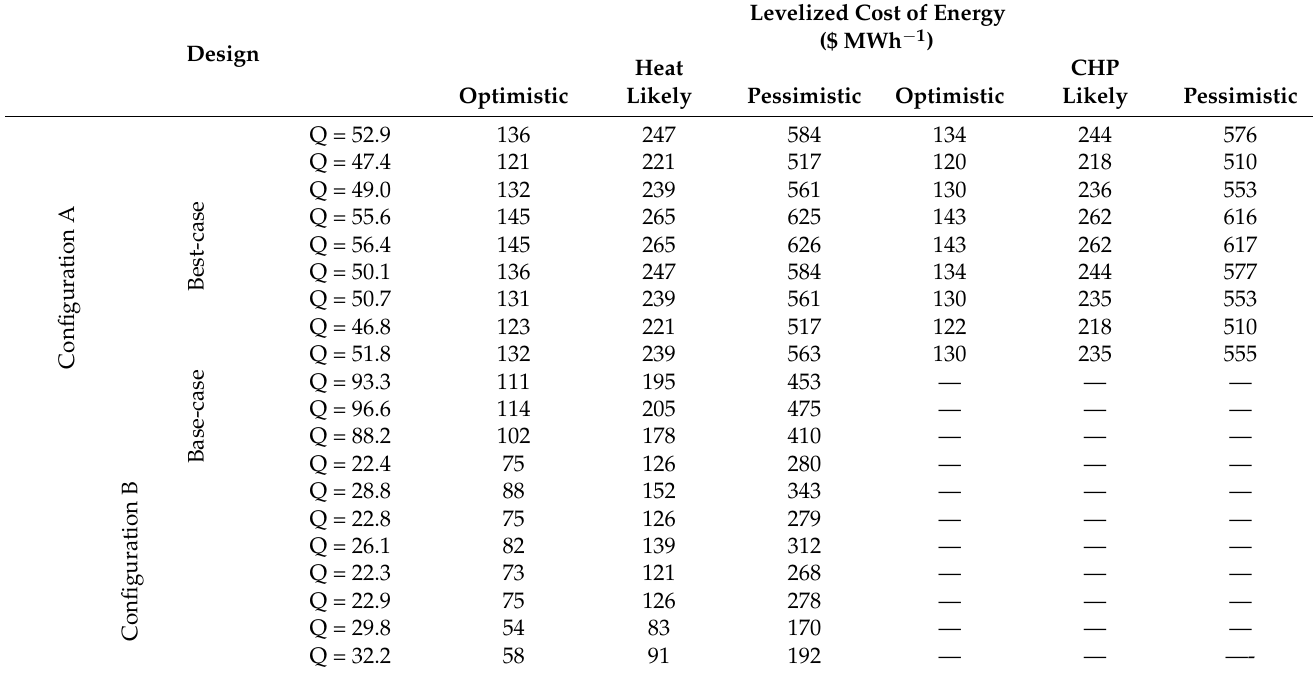
Table 8. Levelized cost of energy for each simulated